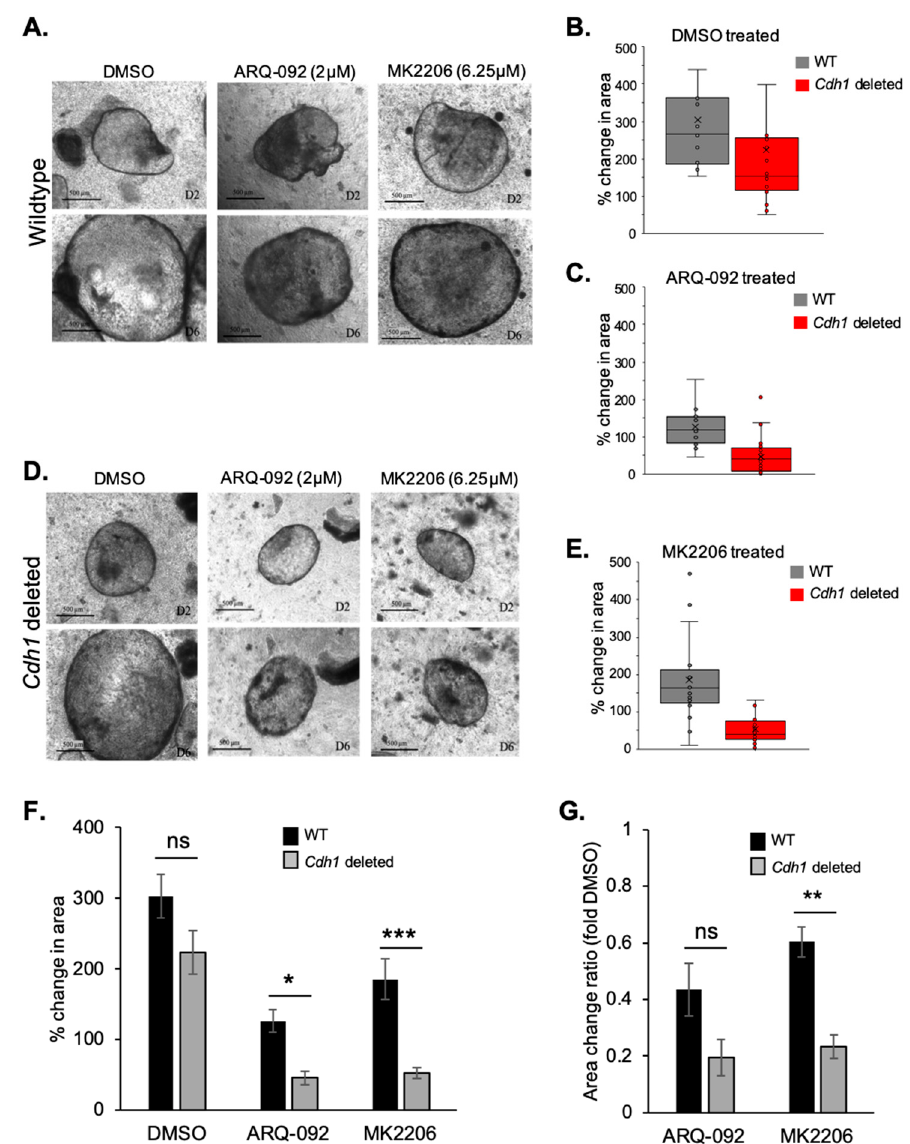
Figure 4. Mouse-derived gastric organoids containing Cdh1 -null cells are more sensitive to the growth-inhibiting effects of allosteric AKT inhibitors. ( A ) Representative photos of wild-type (WT) organoids exposed to DMSO, ARQ-092, or MK2206 on day 2 (top panel) and day 6 (lower panel) of growth. ( B , C ) Box and whisker plots of % change of area of individual organoids treated with DMSO ( B ) or ARQ-092 ( C ). ( D ) Representative photos of organoids containing Cdh1 -null cells exposed to DMSO, ARQ-092, or MK2206 on day 2 and day 6 of growth. ( E ) Box and whisker plots of % change of area of individual organoids treated with MK2206. ( F ) Bar graph showing average % change in area of organoids exposed to DMSO, ARQ-092, or MK2206 for 96 h. ( G ) Bar graph showing the change in area of drug-treated organoids normalised to DMSO-treated organoids. (For all graphs, error bars = SEM; ns: p > 0.05, *: p < 0.05, **: p < 0.01, ***: p < 0.001; n = 3 independent biological replicates; unpaired two-sided t -test.)